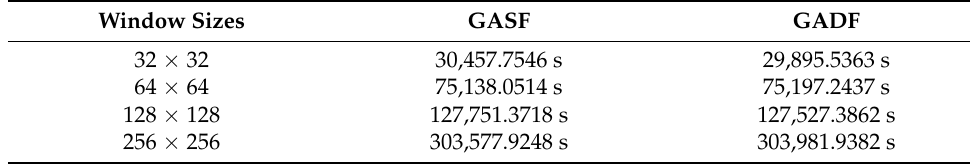
Table 2. The computational time of training with different window sizes.